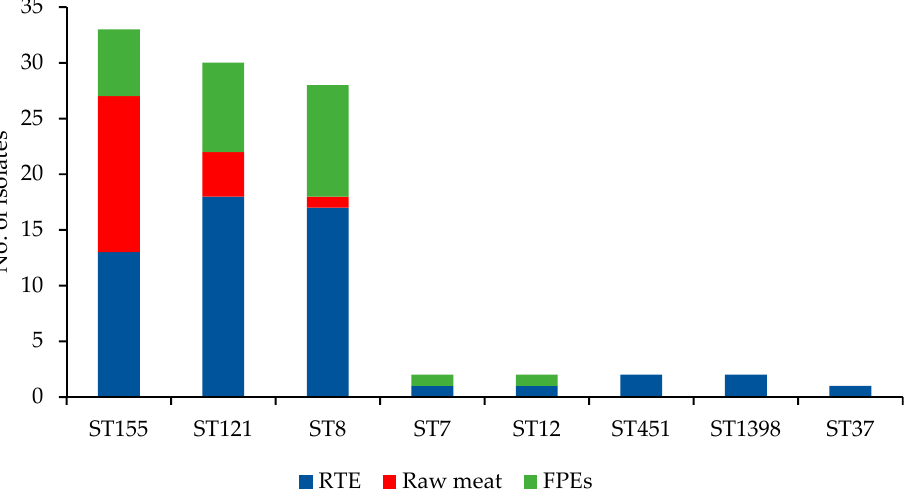
Figure 2. Distribution of sequences types (STs) among of 100 L. monocytogenes isolates tested (RTE, ready-to-eat meat; FPEs, food production environments). Table 1. Prevalence of sequence (ST) and cgMLST (CT) types among L. monocytogenes tested.